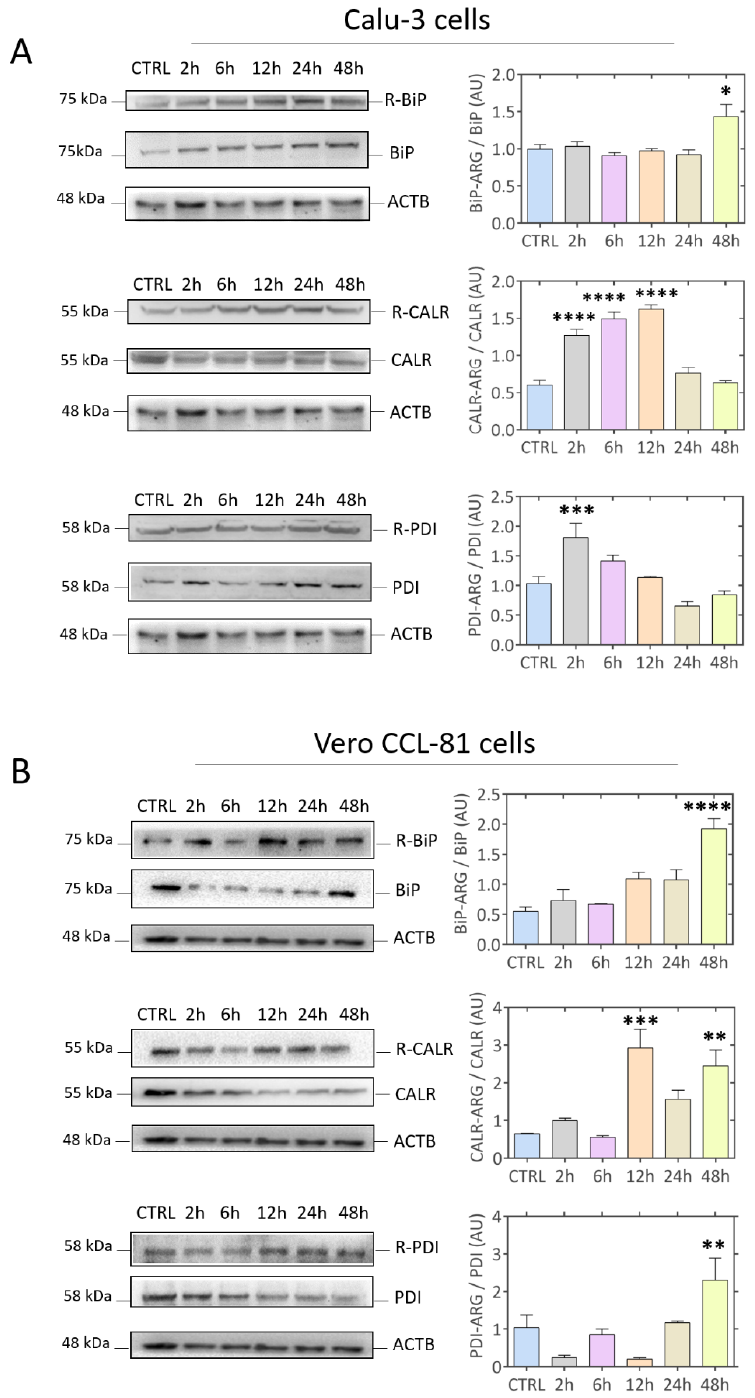
Figure 4. Modulation of arginylated proteins located in the endoplasmic reticulum (ER). ( A ) Representative Western blot images of R-BiP/BiP, R-CALR/CALR, and R-PDI/PDI proteins in Calu-3 and ( B ) Vero CCL-81 cells after 2 h, 6 h, 12 h, 24 h, and 48 h of infection (Wuhan strain). Each point represents an independent experiment ( n = 3). The level of significance indicates: **** p < 0.0001; *** p < 0.001; ** p < 0.005; * p < 0.05 in relation to the control group (CTRL).